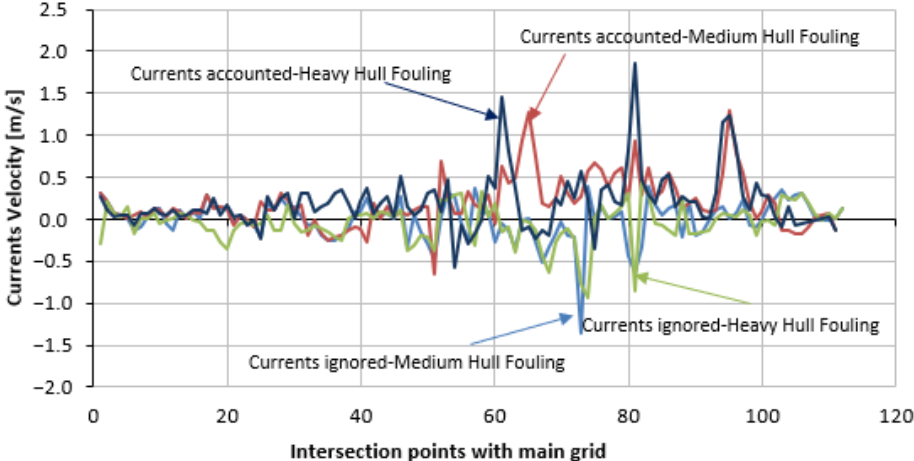
Figure 16. Prevailing current velocity along the optimal routes found with and without the currents’ effects under medium and heavy hull fouling conditions.